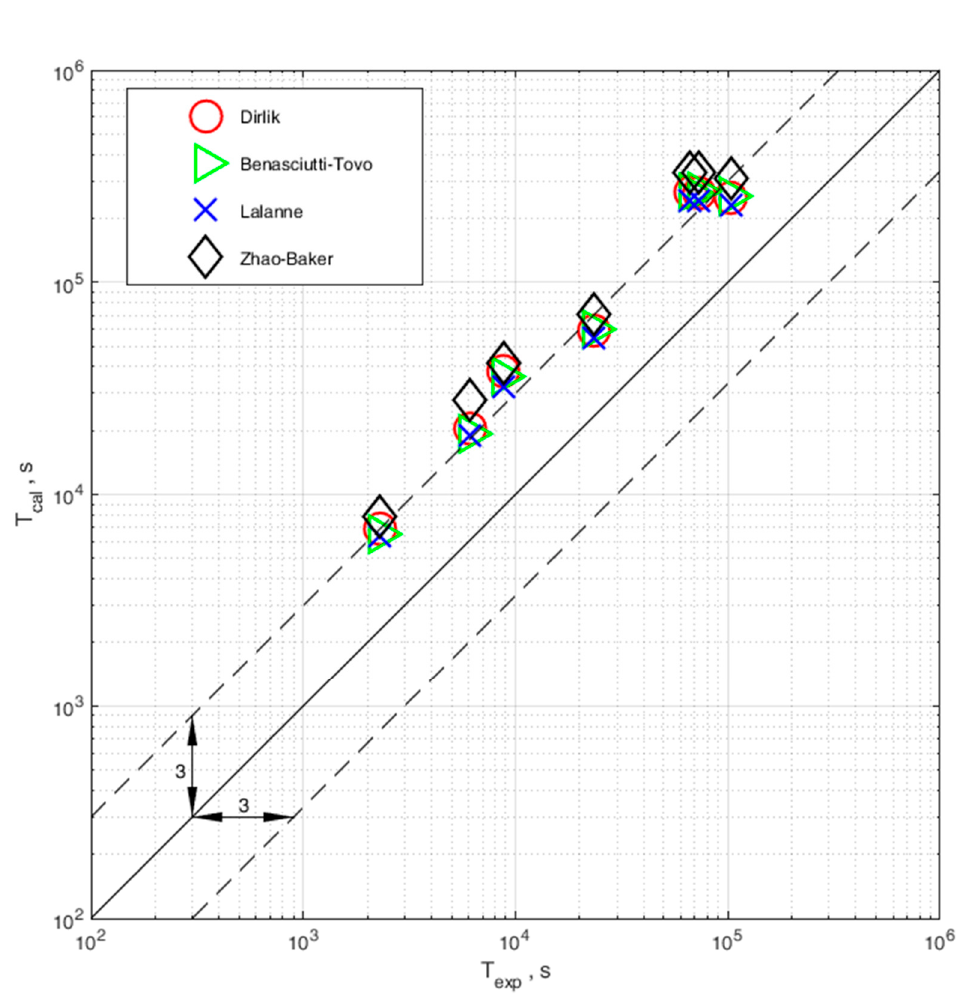
Figure 13. Comparison of experimental and computational durability calculated with the use of four probability density distributions (Dirlik, Benasciutti–Tovo, Lalanne, and Zhao–Baker), but no elastoplastic correction.